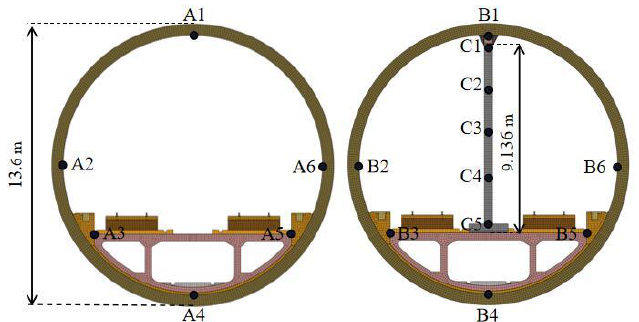
Figure 9. Tunnel model and measuring point location: A1–A6 are the measuring points on the lining and invert of the double-track tunnel; B1–B6 are the corresponding measuring points on the lining and invert of the double-track tunnel with the middle partition wall; C1–C5 are the measuring points on the middle partition wall.